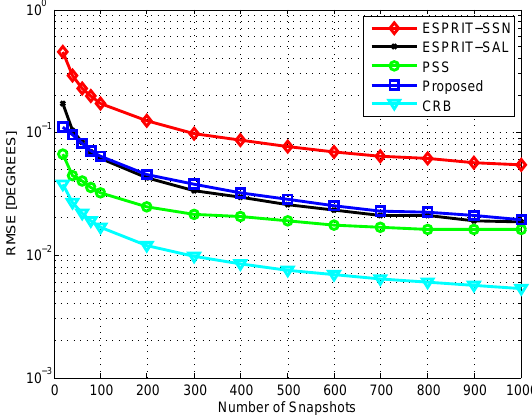
Figure 4. RMSE vs. Snapshot Number, SNR = 5